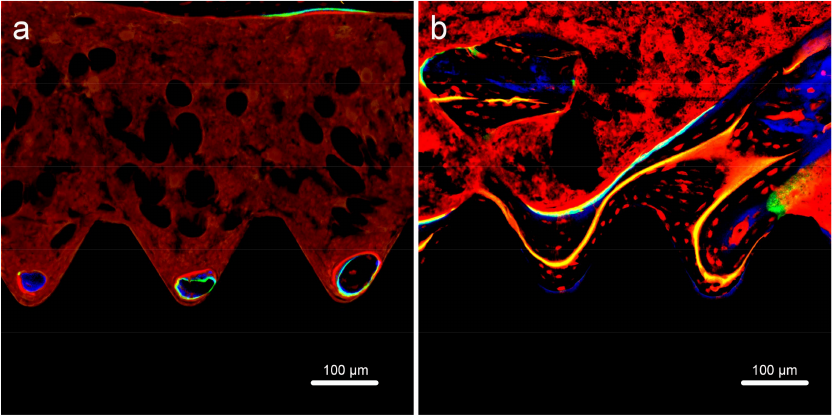
Figure 12. Fluorescent labeling of new bone and mineralization around ( a ) Ti and ( b ) FHA-coated